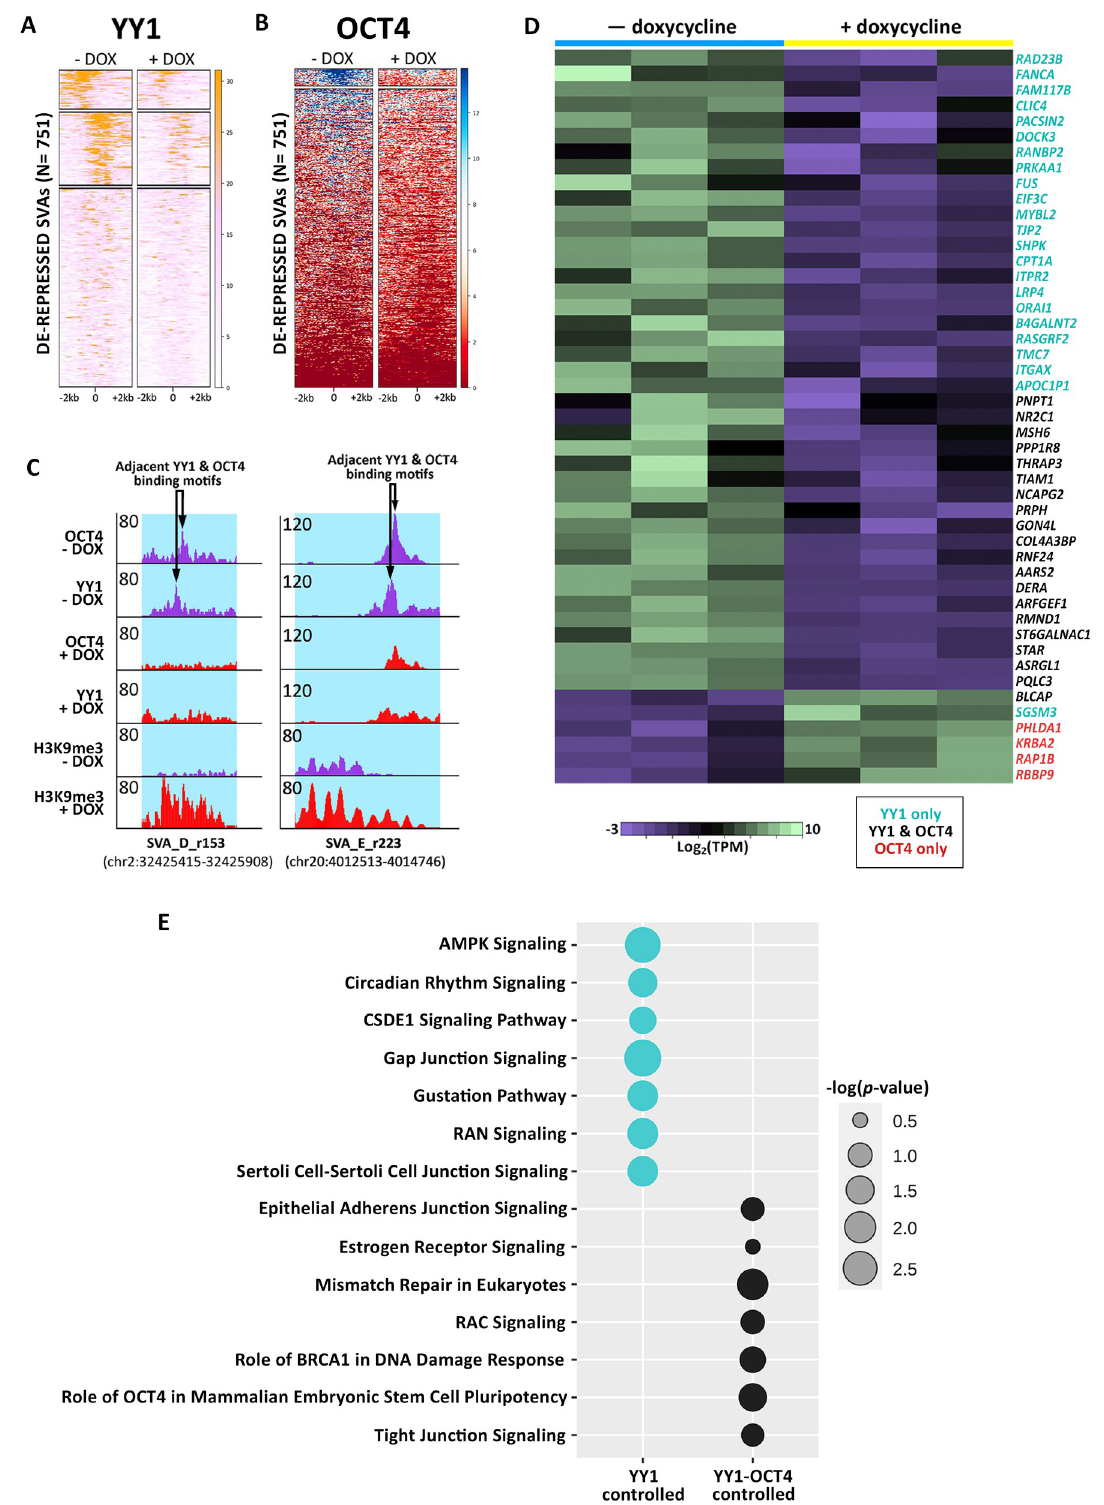
Fig 5. Individual and sequential binding of YY1 and OCT4 contributes to SVA regulatory activity. (A) YY1 ChIP-seq signal at the 751 de-repressed SVAs before and after doxycycline treatment. (B) OCT4 ChIP-seq signal at the 751 de-repressed SVAs before and after doxycycline treatment. (C) Genome browser screenshot displaying the sequential binding of YY1 and OCT4 at a truncated, de-